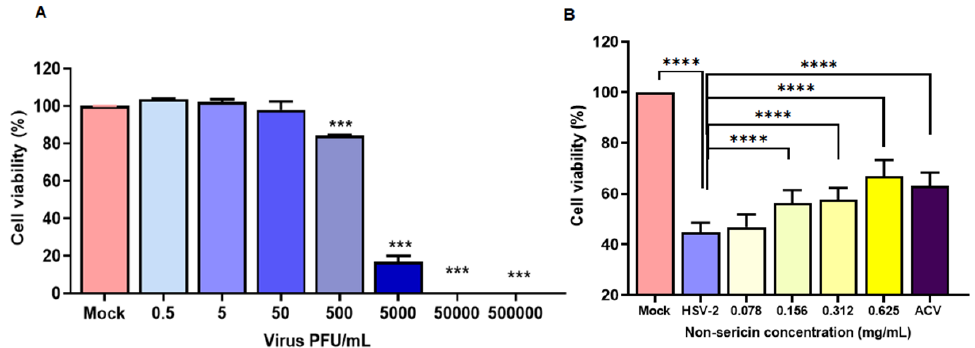
Figure 4. Effect of HSV infection on host cell viability. The cell viability of HeLa after HSV-2 infection ( A ) and the effect of non-sericin treatment to rescue HeLa cell viability were determined ( B ) by using cell viability assay (*** indicates p < 0.001, and **** indicates p < 0.0001).